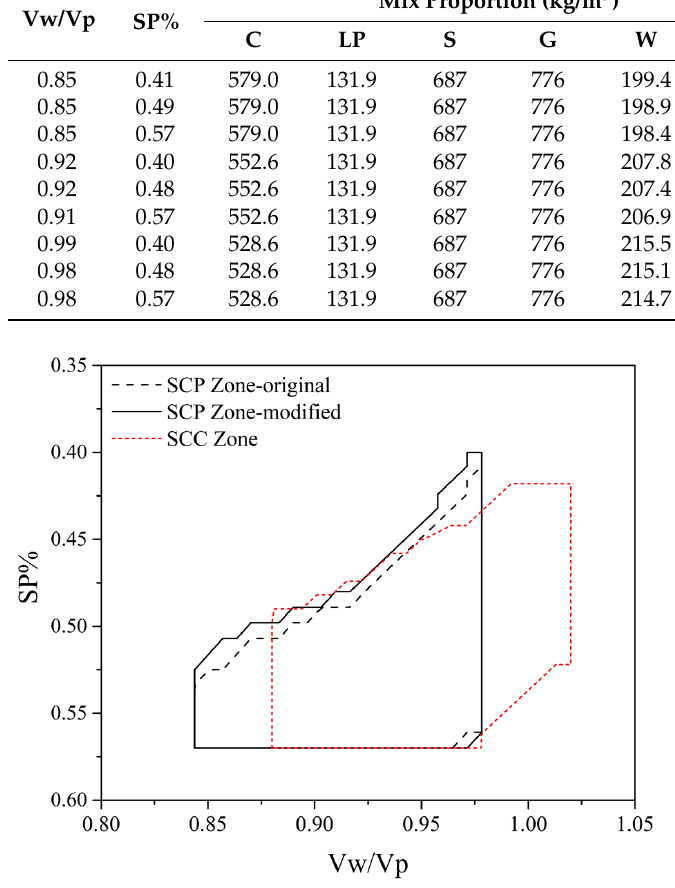
Figure 8. Self-compacting zones of series 4, cement substituted by 20% LP. 3.3.5. Verification with Ternary Powder, Cement Substituted by 16% FA and 21% LP Series 5 used ternary powder, cement (C_B), FA, and LP. The substitution rate of LP was 20% by volume. The gravel and sand types were G_B and S_B, respectively, with a gravel content of 280 L/m 3 and a sand ratio of 38.5%. The detailed mix and test results of paste SCC are shown in Tables 12 and 13. τ paste and η paste in Table 12 were calculated by Equations (5) and (6). Table 12. Mix proportions and test results of paste in series 5.